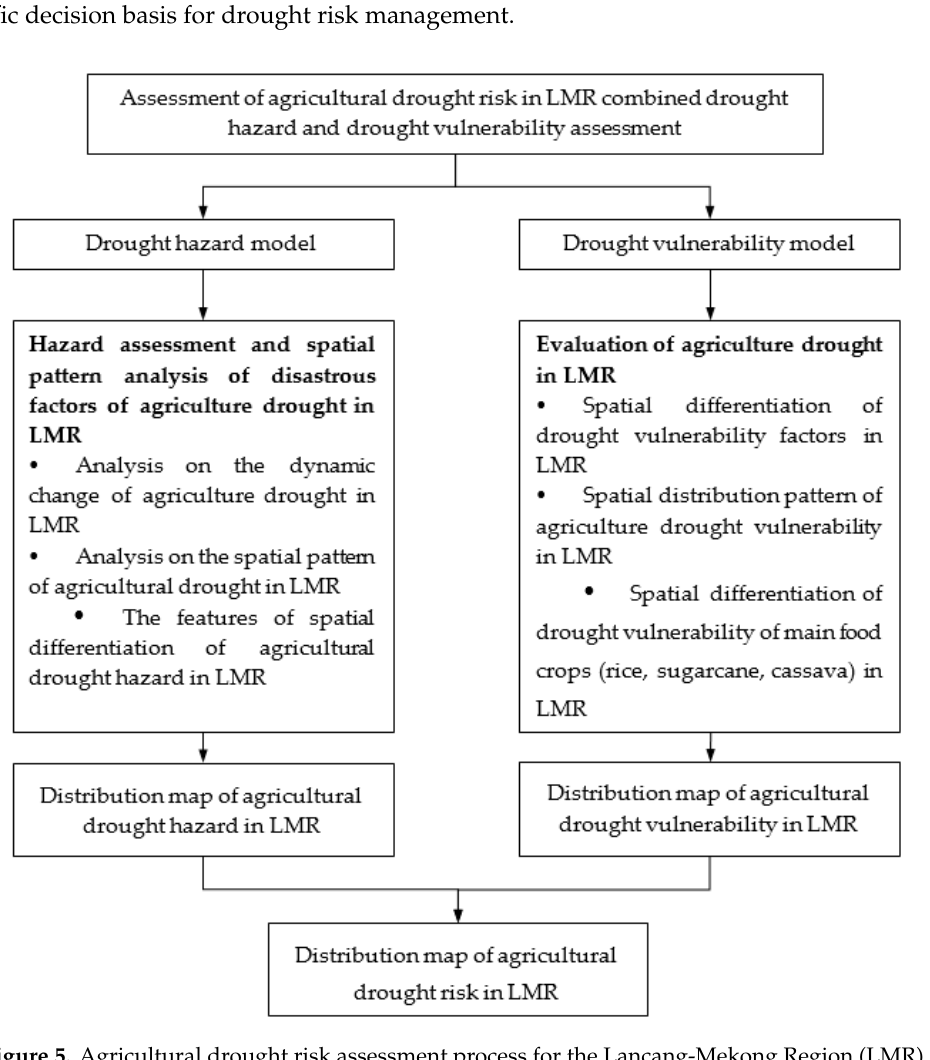
Figure 5. Agricultural drought risk assessment process for the Lancang-Mekong Region (LMR).